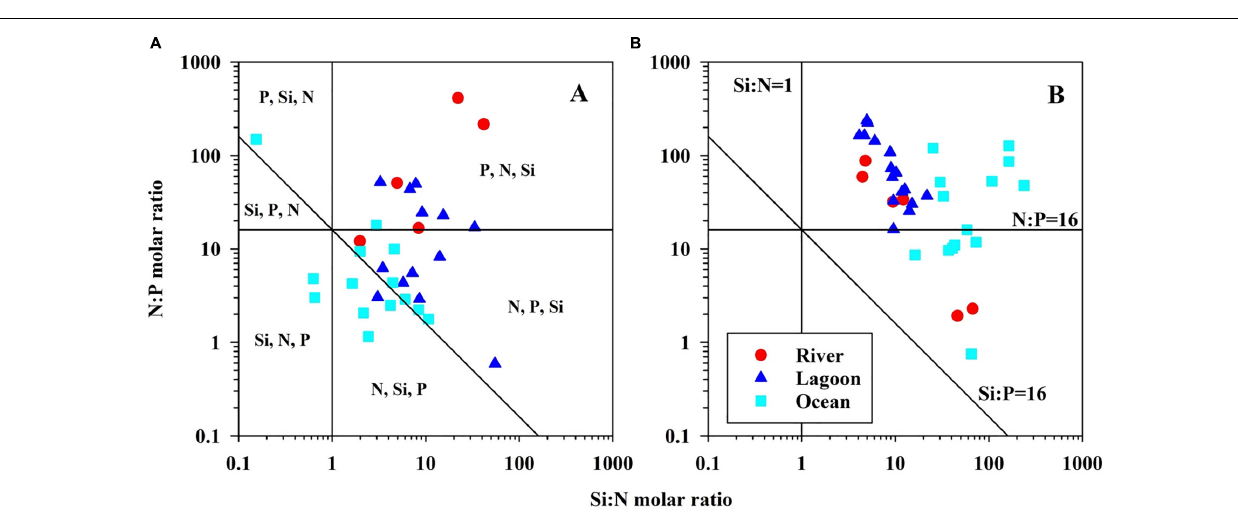
FIGURE 5 | Molar ratio of Si:N:P in Negombo lagoon in dry season (A) and wet season (B) . The potentially limited nutrients are divided from Redfield ratio (Si:N:P = 16:16:1). Different area in the plot was characterized by potentially limited nutrients in order of priority (Rocha et al.,